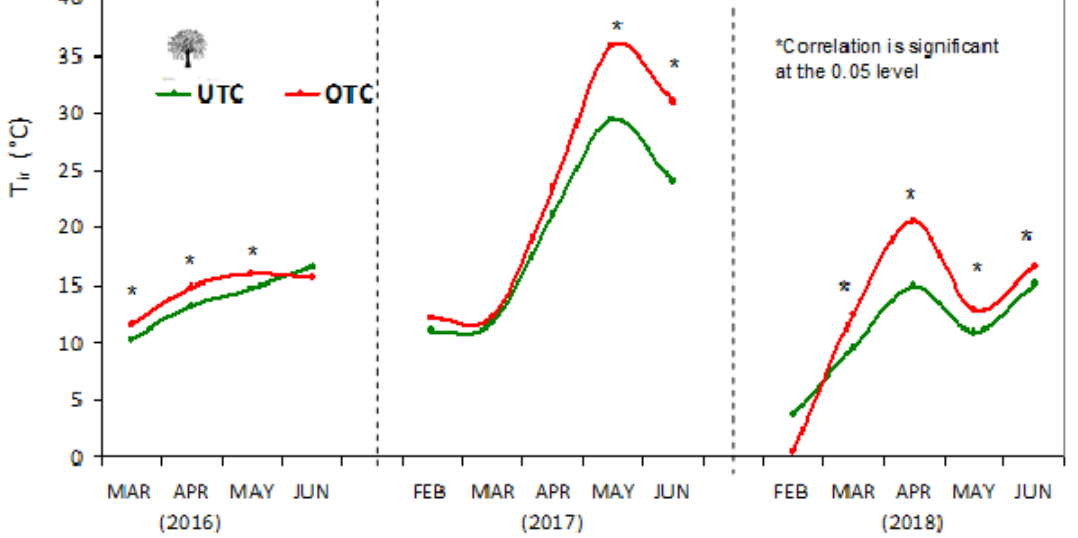
Figure 8. Monthly pasture surface temperature (T ir ) under tree canopy (UTC) and outside tree canopy (OTC) between February or March and June of 2016, 2017, and 2018. *—Correlation is significant at the 0.05 level.